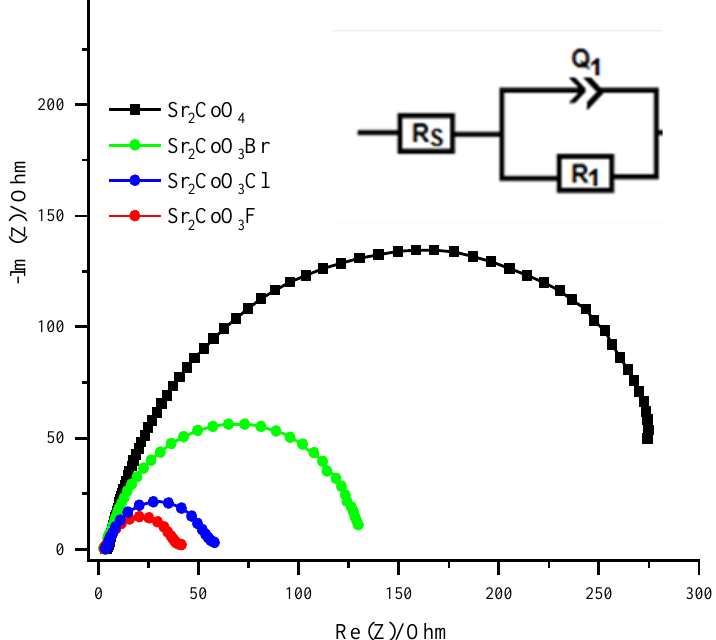
Figure 6. EIS Nyquist diagram and equivalent circuit of the oxyhalides and parent Sr 2 CoO 4 electrodes (loading of 0.8 mg/cm 2 ) in 1.0 M NaOH solution at 1.55 V versus HRE and within the frequency range of 0.01 to 1.0 MHz with a 20 mV amplitude. The solid lines are the fitted curves and the symbols are representing the experimental data.